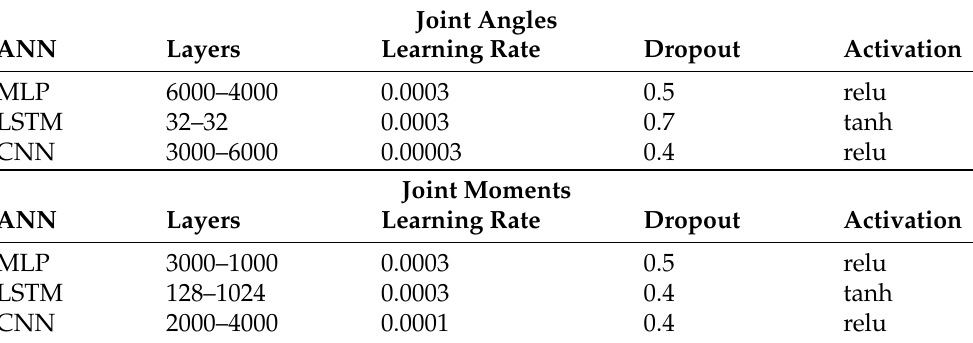
Table 1. Neural Network architectures and